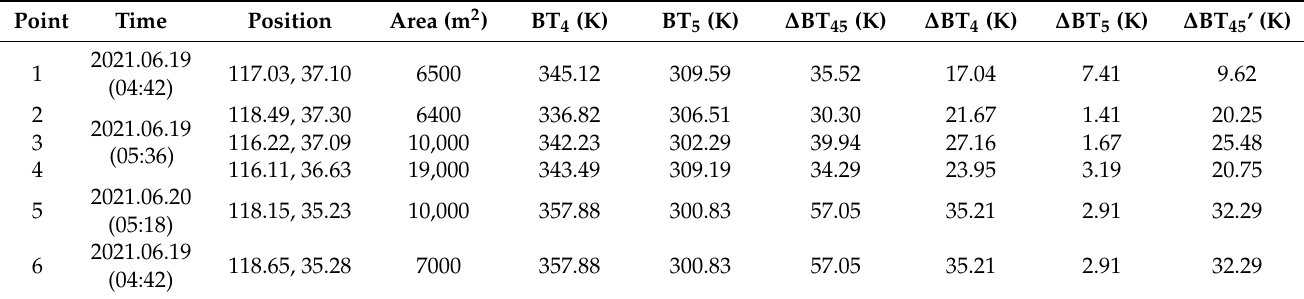
Table 3. Fires missing from summer VIIRS fire products that were recovered by the improved algorithm.